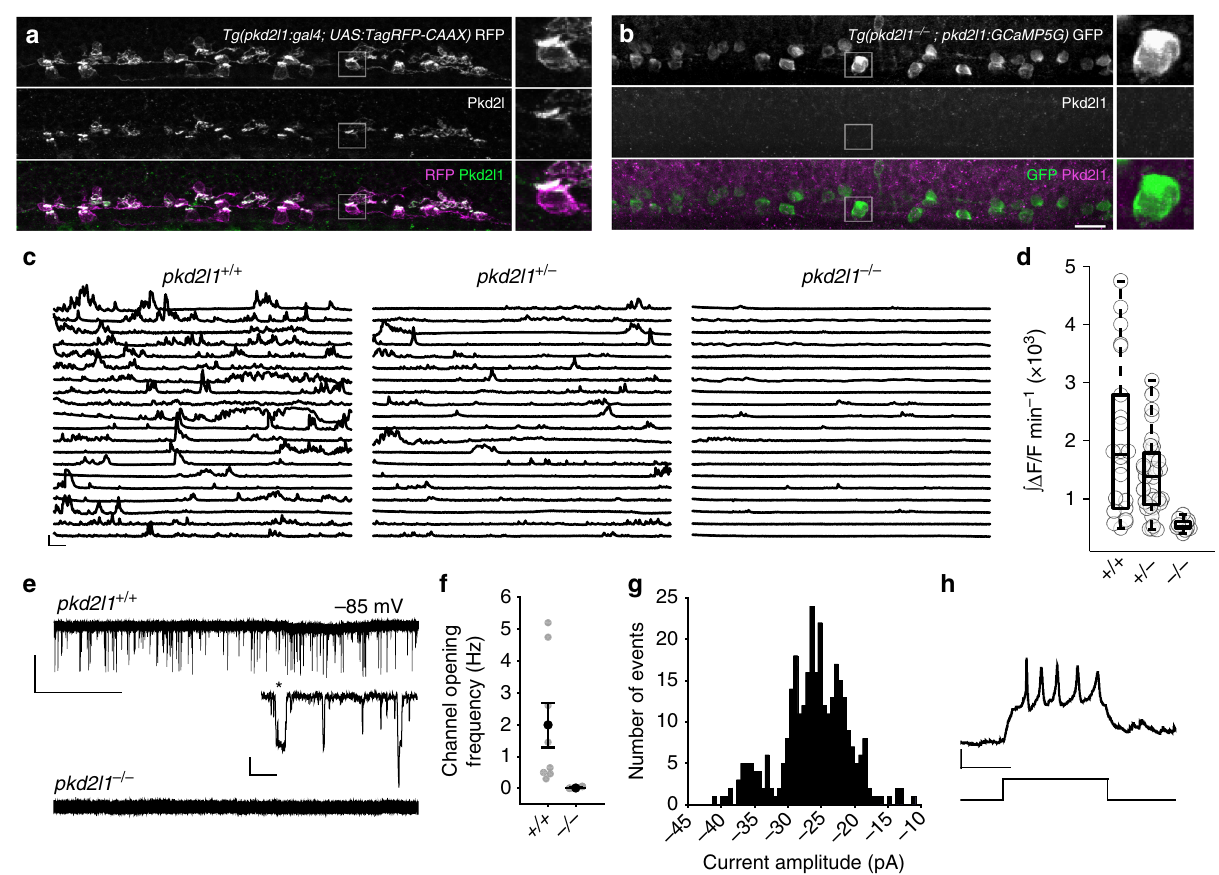
Fig. 3 Spontaneous activity in CSF-contacting neurons requires Pkd2l1. Immunohistochemistry for zebra fi sh Pkd2l1 in 30 hpf a Tg(pkd2l1:gal4; UAS:TagRFP- CAAX) or b Tg(pkd2l1 − / − ; pkd2l1:GCaMP5G) embryos. Right: magni fi cation of the area in the gray box. No Pkd2l1 was detected in pkd2l1 − / − embryos. Scale: 20 µ m. c Calcium imaging traces from ventral CSF-cNs in 24 – 26 hpf Tg(pkd21l:GCaMP5G) embryos. Traces represent cells with the median integral values taken from all embryos. Scale: 30 s, 100% Δ F/F. d Integral quanti fi cation of CSF-cN calcium activity. Each point re fl ects the average calcium activity for all cells from one embryo ( n = 22 pkd2l1 + / + , n = 32 pkd2l1 + / − , n = 12 pkd2l1 − / − embryos, p = 1.94 × 10 ‒ 13 , comparison between pkd2l1 + / + and pkd2l1 − / − , linear mixed models). The central mark on the box plot indicates the median, the bottom and top edges of the box indicate the 25th and 75th percentiles. The whiskers extend to the most extreme data points not considered outliers. e Gap-free voltage-clamp (VC) recordings from ventral CSF-cNs show CSF-cNs of pkd2l1 + / + and pkd2l1 − / − embryos ( n = 8 pkd2l1 + / + CSF-cNs from eight embryos, n = 3 pkd2l1 − / − CSF-cNs from two embryos).